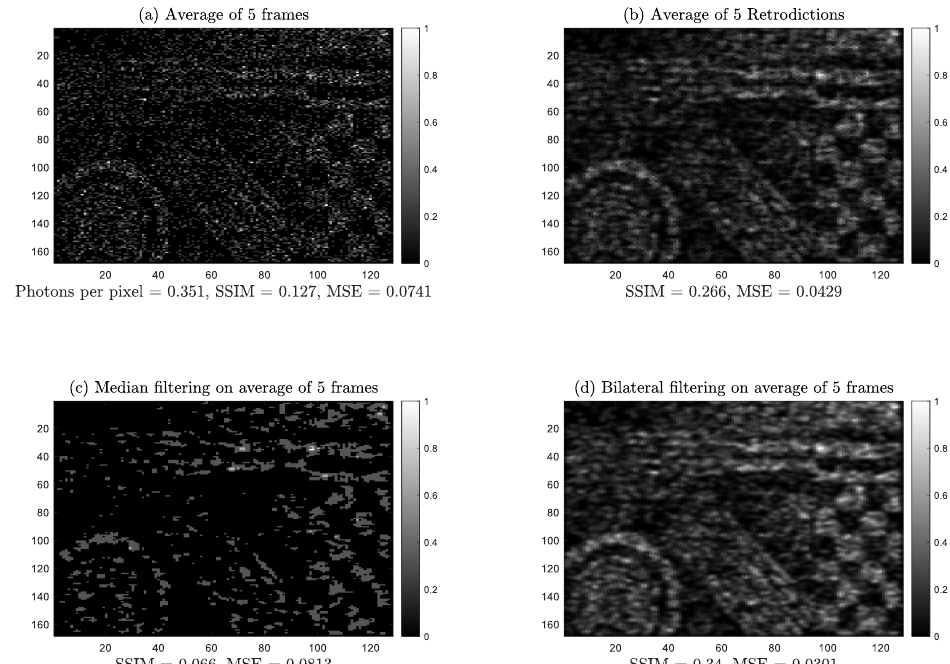
Figure 5. Image reconstruction of 5 × 0.1 µ s exposure frames from the SPAD camera, with a total of 0.351 photons per pixel. ( a ) Shows the result of averaging across these twenty frames, ( b ) the average of the retrodictions of the twenty frames, ( c ) is the result of median filter, over a 3 × 3 pixel region, being applied to ( a , d ) the results of a bilateral filter applied to ( a ). SSIM and MSE results are shown for each of the